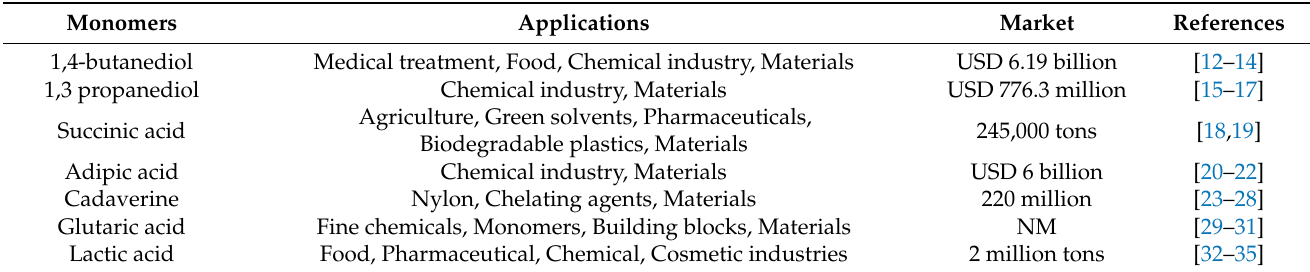
Table 1. Applications and market potential of bioplastics monomers.